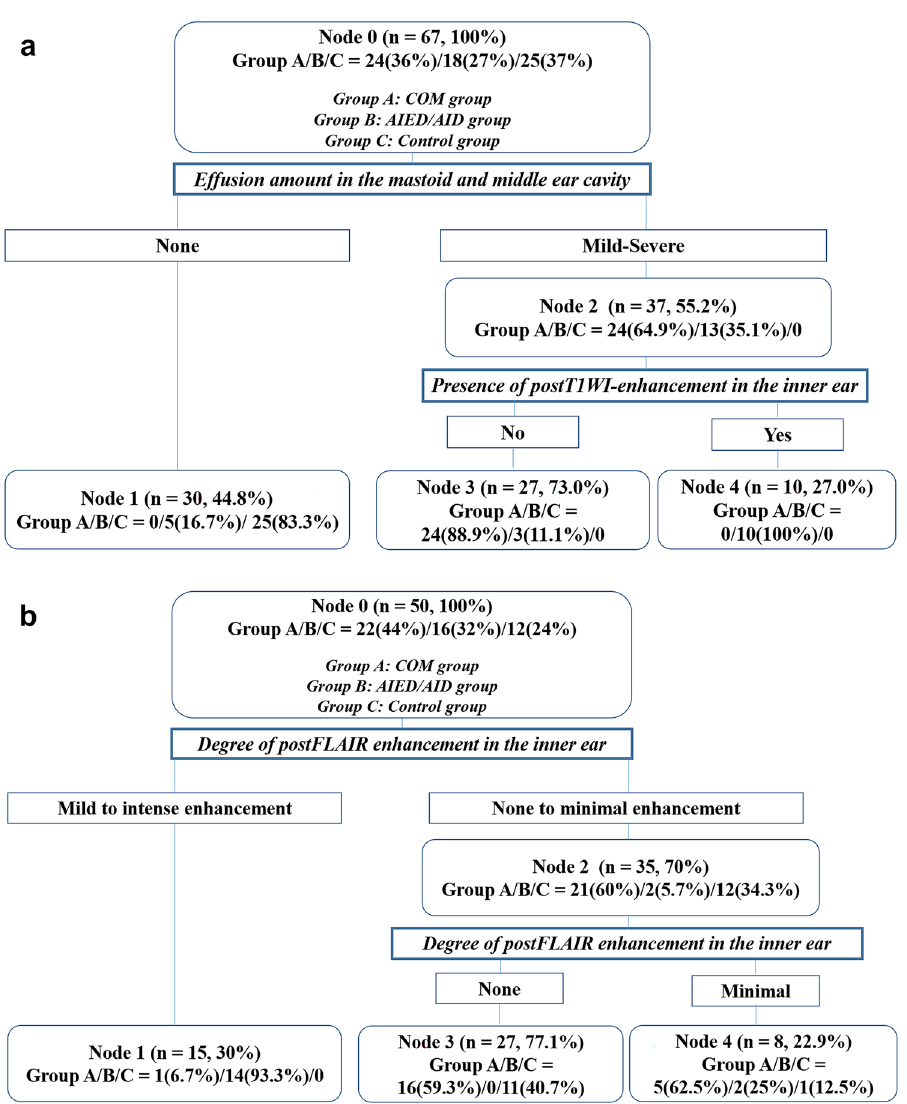
Figure 2. Classification and regression tree analysis (CART) results. The first decision-making tree ( a ) uses two nodes of the amount of effusion in the mastoid and middle ear cavity and the presence of enhancement in the inner ear structures on post-contrast T1-weighted images (postT1WI). The second decision-making tree ( b ) utilized the degree of enhancement in the inner ear structures on post-contrast FLAIR images (postFLAIR) as the partitioning node. Group A was the chronic otitis media (COM) group, group B was the autoimmune inner ear disease and autoinflammatory inner ear disease (AIED/AID) group, and group C was the control group. The details regarding the tree are explained in the “Results”